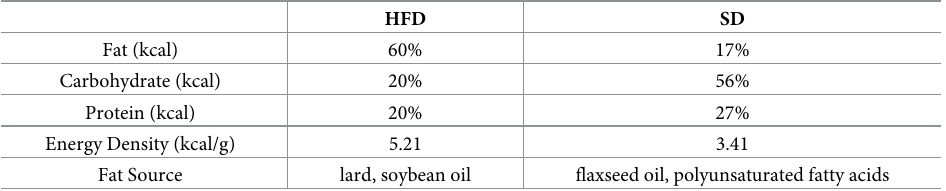
Table 1. Macronutrient composition (Niepoetter et al. 2021).